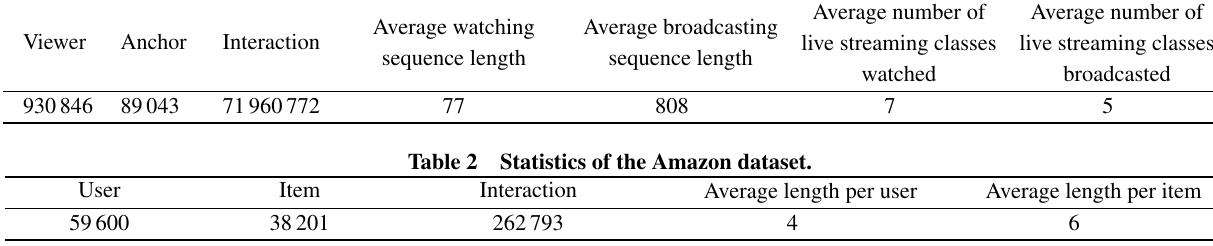
Table 1 Statistics of live streaming dataset.